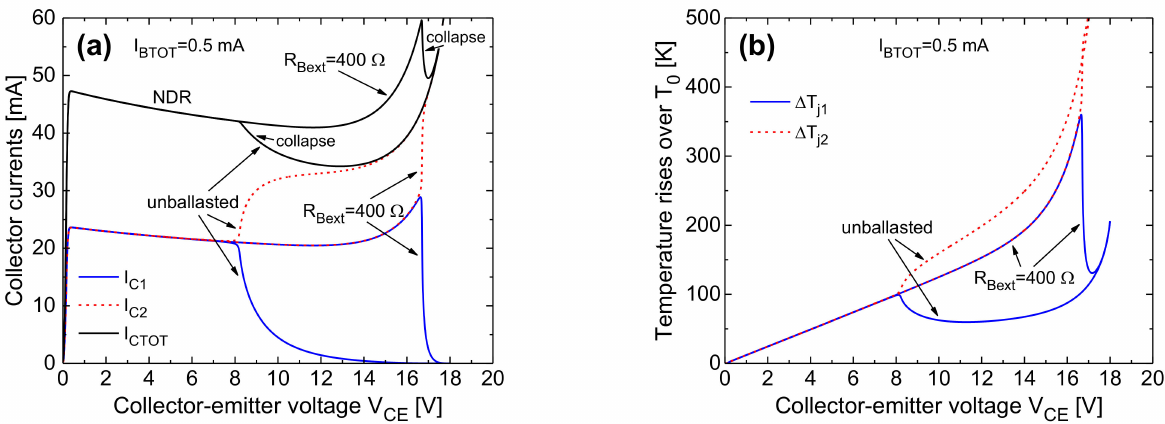
Figure 12. Test device with two unit cells: simulated ( a ) collector currents and ( b ) temperature rises over T 0 vs. collector- emitter voltage V CE for I BTOT = 0.5 mA. Both the unballasted case and that ballasted with R Bext = 400 Ω per cell are